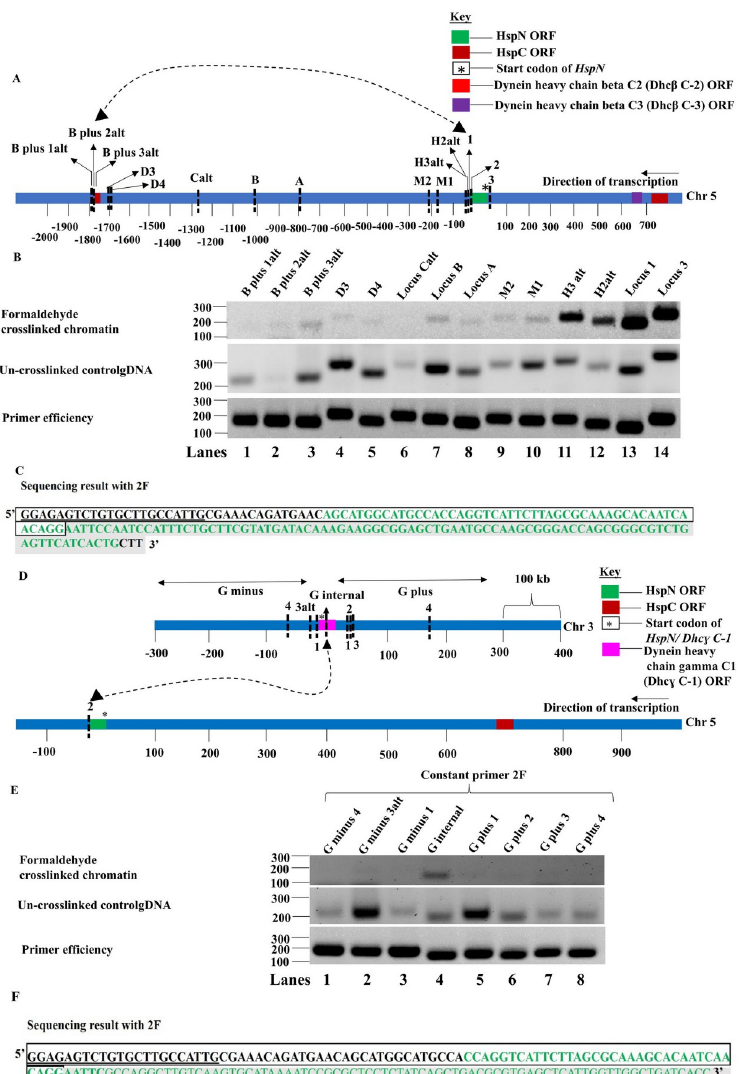
Fig 4. HspN physically interacts with Dhc β C-2 and Dhc ɣ C-1 in the nucleus. A) Schematic representation of loci chosen to investigate the interaction between HspN and Dhc β C-2 ORFs. B) First panel shows the PCR products obtained with constant primer 2F with other forward primers across the different loci in vicinity and in between HspN and Dhc β C-2 ORFs. Loci 1 and 3 which are in proximity to locus 2 show intense bands of corresponding sizes. As the distance from locus 2 towards the Dhc β C-2 increases, the PCR amplicons fade out and the PCR signal then picks up at locus B and then at locus B plus 3alt confirming physical proximity and interaction between loci 2 and B plus 3alt which are proximal to HspN and Dhc β C-2 ORFs respectively. Second Panel shows randomly obtained hybrids with control gDNA digested and ligated without dilution. Third panel shows PCR amplicons of equal intensities with 2F constant primer and other forward primers indicating equal primer efficiencies. C) The enriched hybrid formed from locus 2 and locus B plus 3alt (Fig 4B, panel 1-lane 3) was excised and subjected to sanger’s DNA sequencing with 2F primer. Sequencing result with 2F as the primer could detect the presence of sequences from locus 2 and locus B plus 3alt which confirms the presence of hybrid. E) First panel shows the PCR products obtained with constant primer 2F with other forward primers across the different loci in vicinity and within Dhc ɣ C-1 ORF on chromosome 3 chosen for this study. Loci within Dhc ɣ C-1 forms enriched hybrid 3C product with locus 2F in the 3C library preparation. Other loci on either side of Dhc ɣ C-1 show very faint or no amplification with 2F confirming interaction of HspN with Dhc ɣ C-1 on chromosome 3. Un-crosslinked control gDNA displays randomly varying intensity of hybrid products indicating that the control template library has randomly ligated products. Third panel shows equal intensities of amplicons indicating equal primer efficiencies. F) The enriched hybrid formed from locus 2 and locus G internal (Fig 4E, panel 1-lane 4) was excised and subjected to sanger’s DNA sequencing with 2F primer. Sequencing result with 2F as the primer could detect the presence of sequences from locus 2 and locus G internal which confirms the presence of